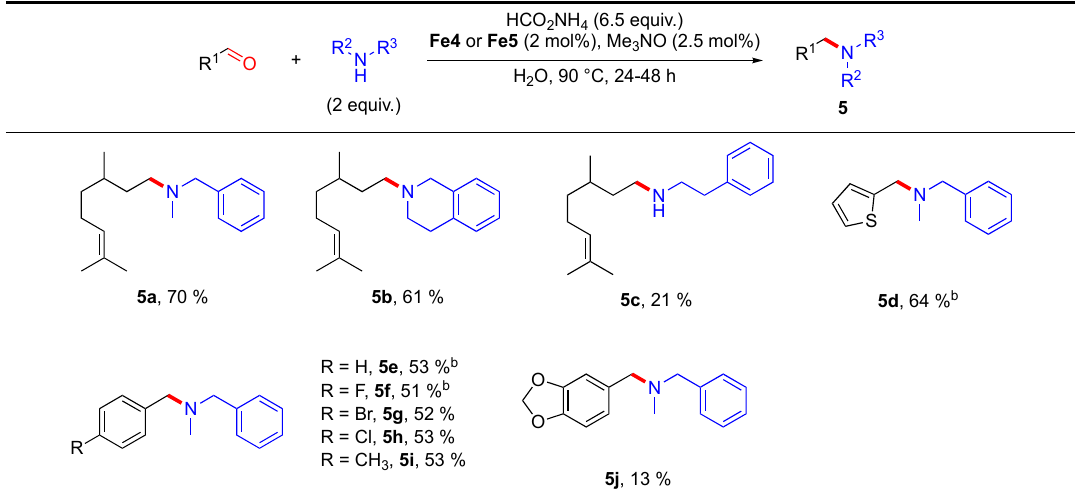
Table 4. Iron-catalyzed reductive amination with ammonium formate a .